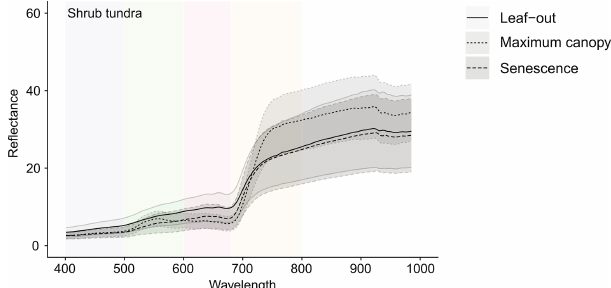
Figure 16. Canopy-level spectral reflectance in percent as a func- tion of wavelength in nanometers from a dwarf shrub community in three major phenological phases of leaf-out, maximum canopy, and senescence (Beamish et al.,